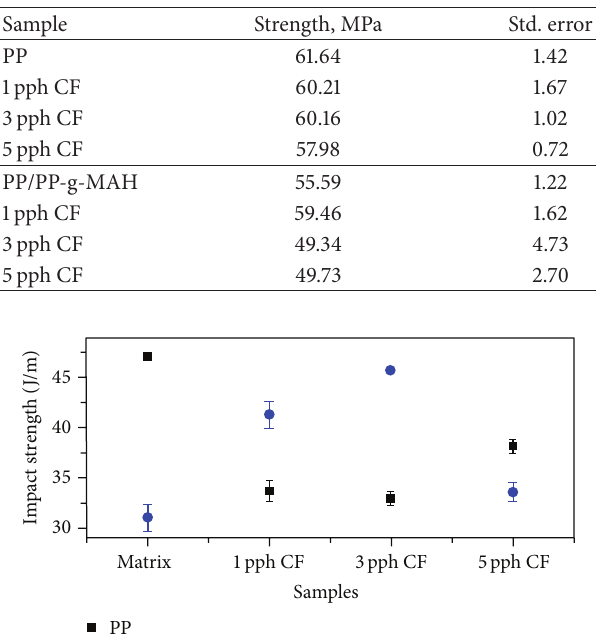
Table 6: Yield strength of the injection moulded composites.